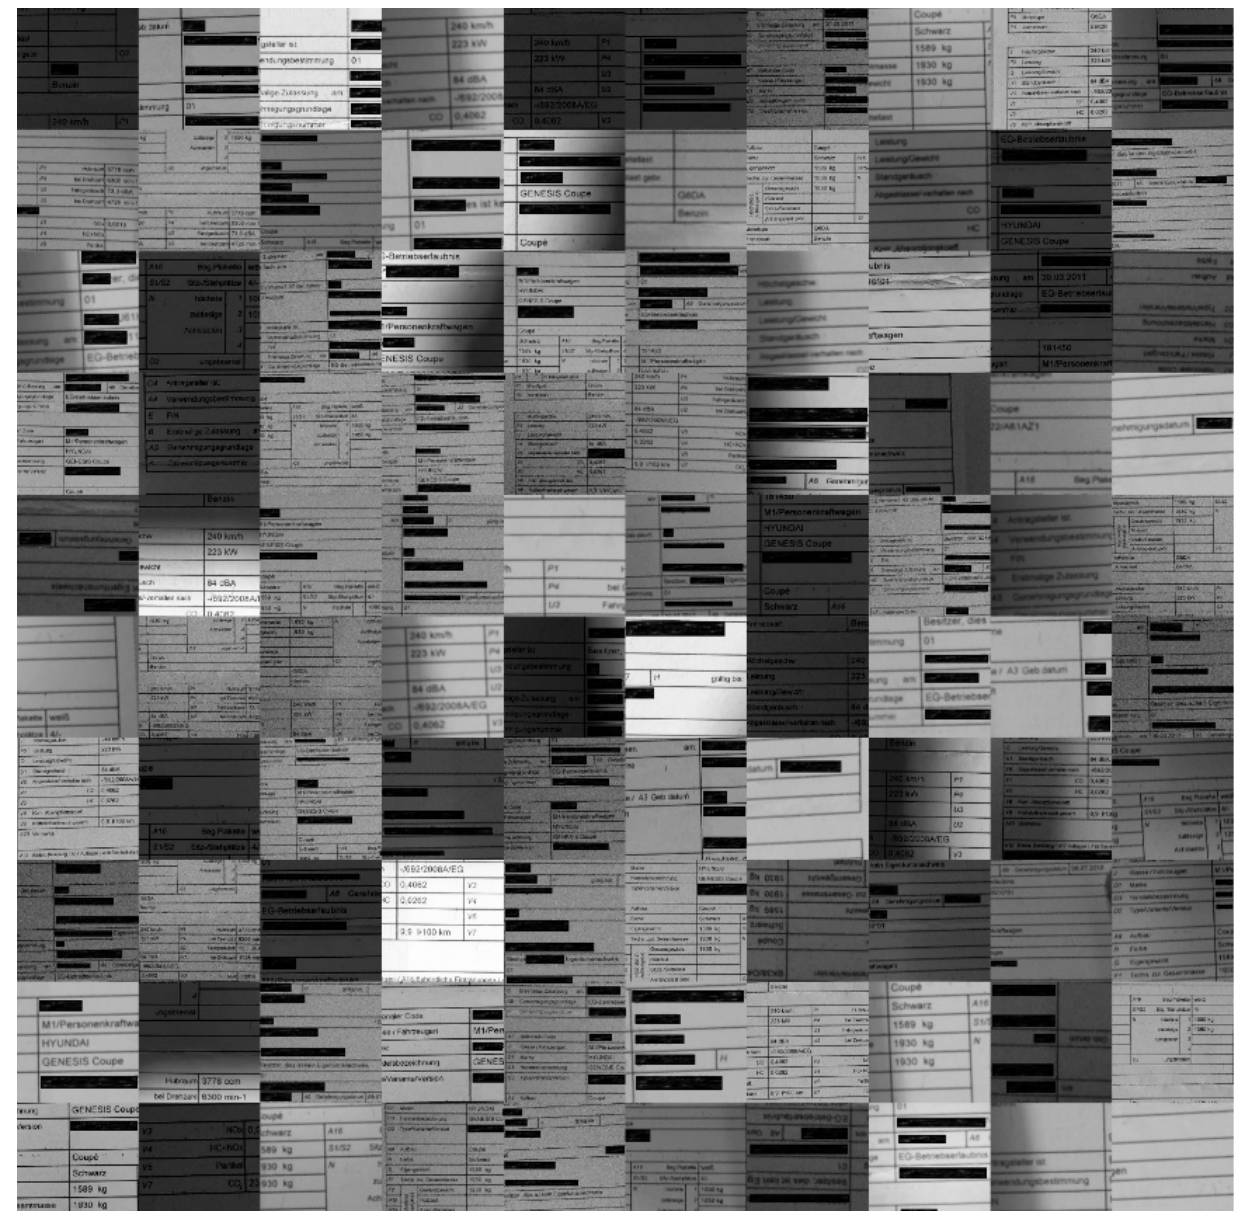
Figure 6. These are 100 “very bad quality” representative sample data (an extract from a much bigger dataset). Note: since the images contain some personal data, those parts are covered by black rectangles for privacy reasons.